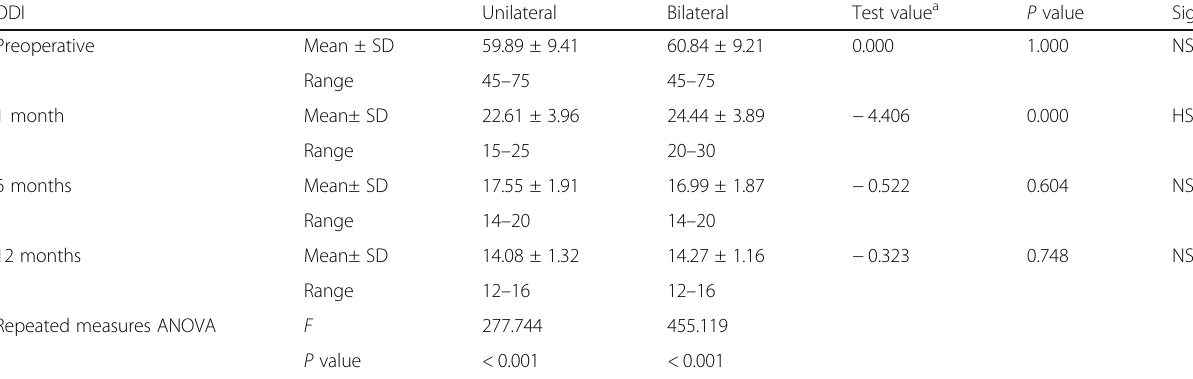
Table 3 Comparison between unilateral group and bilateral group regarding the Oswestry disability index ODI ODI Unilateral